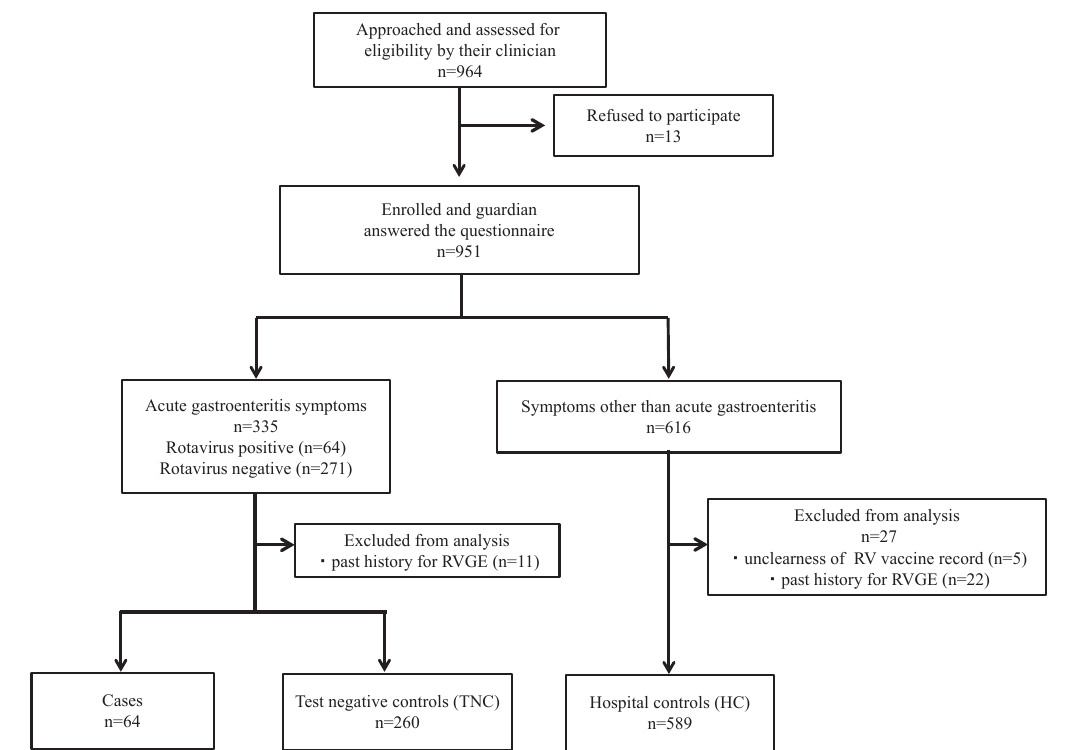
Figure 1. Flow chart of enrollment of rotavirus gastroenteritis cases, test-negative controls, and hospital controls. RVGE, rotarvirus